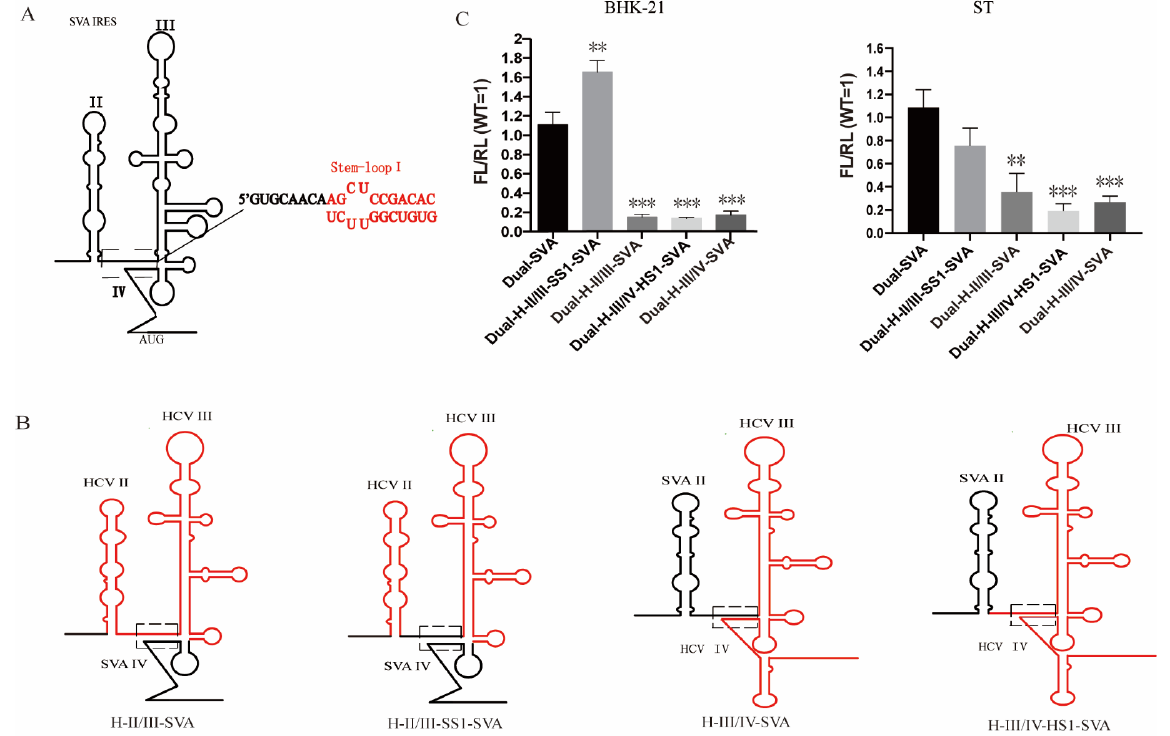
Figure 3. IRES activities of SVA chimera perturbing stem-loop I structure with replacement of double IRES domains. ( A ) The secondary structure of IRES stem-loop I of SVA; ( B ) The secondary structure of stem-loop I of the IRES-chimeric SVA with replacement of domains II and III or domains III and IV. The red and black regions represent the replacement of the HCV IRES and SVA IRES, respectively ( C ) IRES activities of IRES-chimeric SVA with replacement of double IRES domains. Data in panel C are presented as the mean ± SD ( n = 3). Significance of the changes were analyzed by Student’s t -test and indicated by *** p < 0.001, ** p < 0.01.